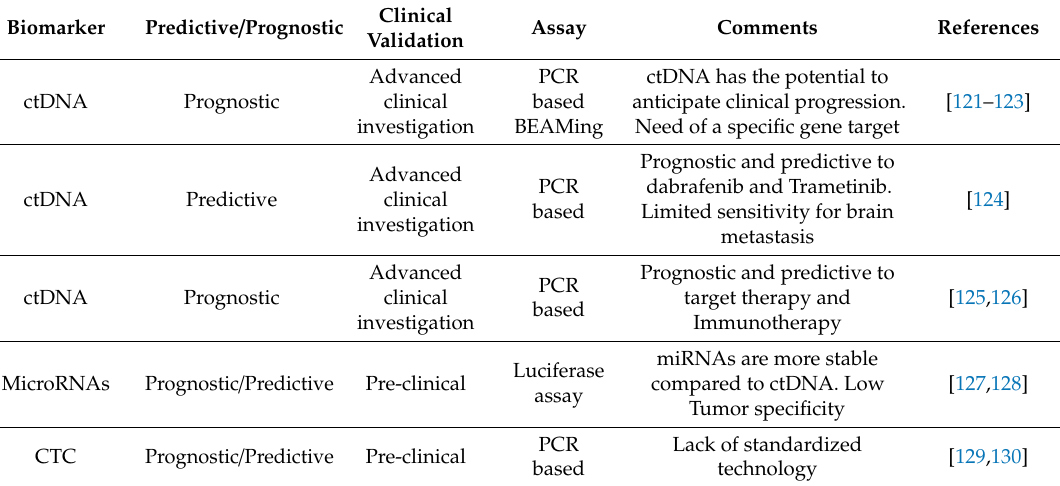
Table 3. Circulating nucleic acids or tumor cells as biomarkers for